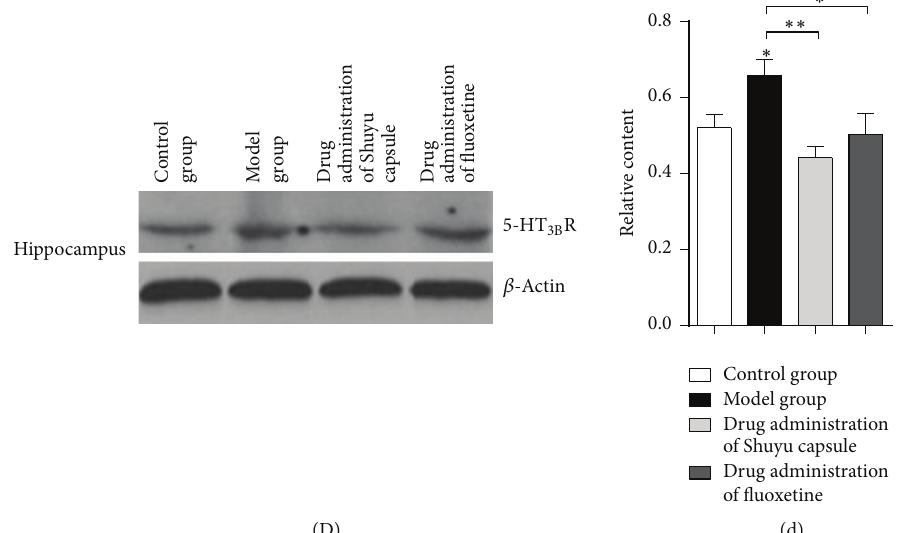
Figure 2: Western blot and analysis of tissue samples. Western blots of frontal lobe samples (A, C) and hippocampus samples (B, D) from each group, including the control/normal group, model group, Shuyu capsule group, and positive-control fluoxetine group. 5-HT R protein levels among the groups, while 5-HT used (A, B) to define 5-HT 3A A quantitative analysis ( 𝑛 = 6 ) of western blot results (a–d) was performed ( ∗ 𝑃 < 0.05 , ∗∗ 𝑃 < 0.01 , and ∗∗∗ 𝑃 < 0.001